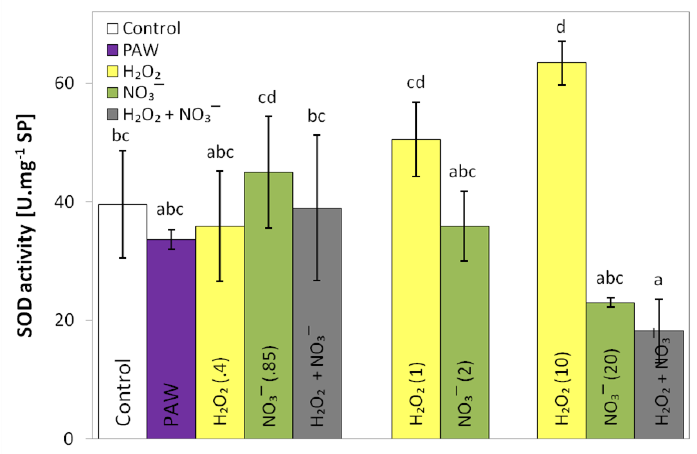
Figure 6. Activity of superoxide dismutase (SOD) in the above-ground parts of lettuce plants after 5 weeks of soil cultivation irrigated with the plasma activated water (PAW), solutions of various concentrations of H 2 O 2 (0.4, 1, 10 mM), NO 3− (0.85, 2, 20 mM), H 2 O 2 + NO 3− (0.4 mM + 0.85 mM, 10 mM + 20 mM), and control irrigated with tap water. The data are presented as mean values ± standard deviation from 3 independent repetitions. The lowercase letters represent statistically significant difference at probability p < 0.05.